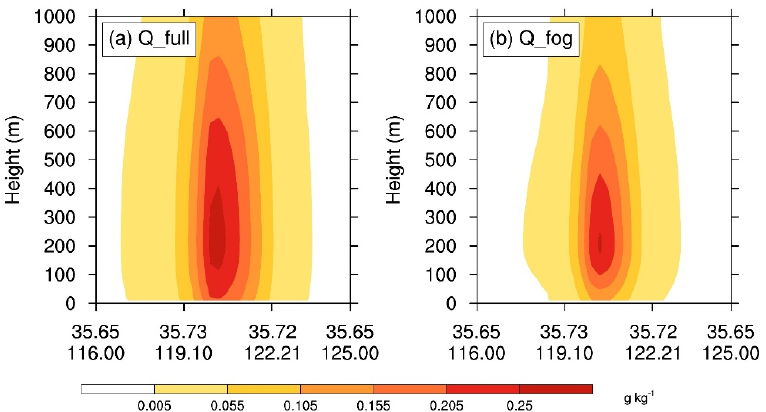
Figure 7. Vertical cross ‐ sections of water vapor mixing ratio increments (shaded; g kg − 1 ) below 1000 m across the location of the assimilated point valid at 1900 UTC 28 April 2007 in single ‐ observation experiments for ( a ) Q_full and ( b ) Q_fog.